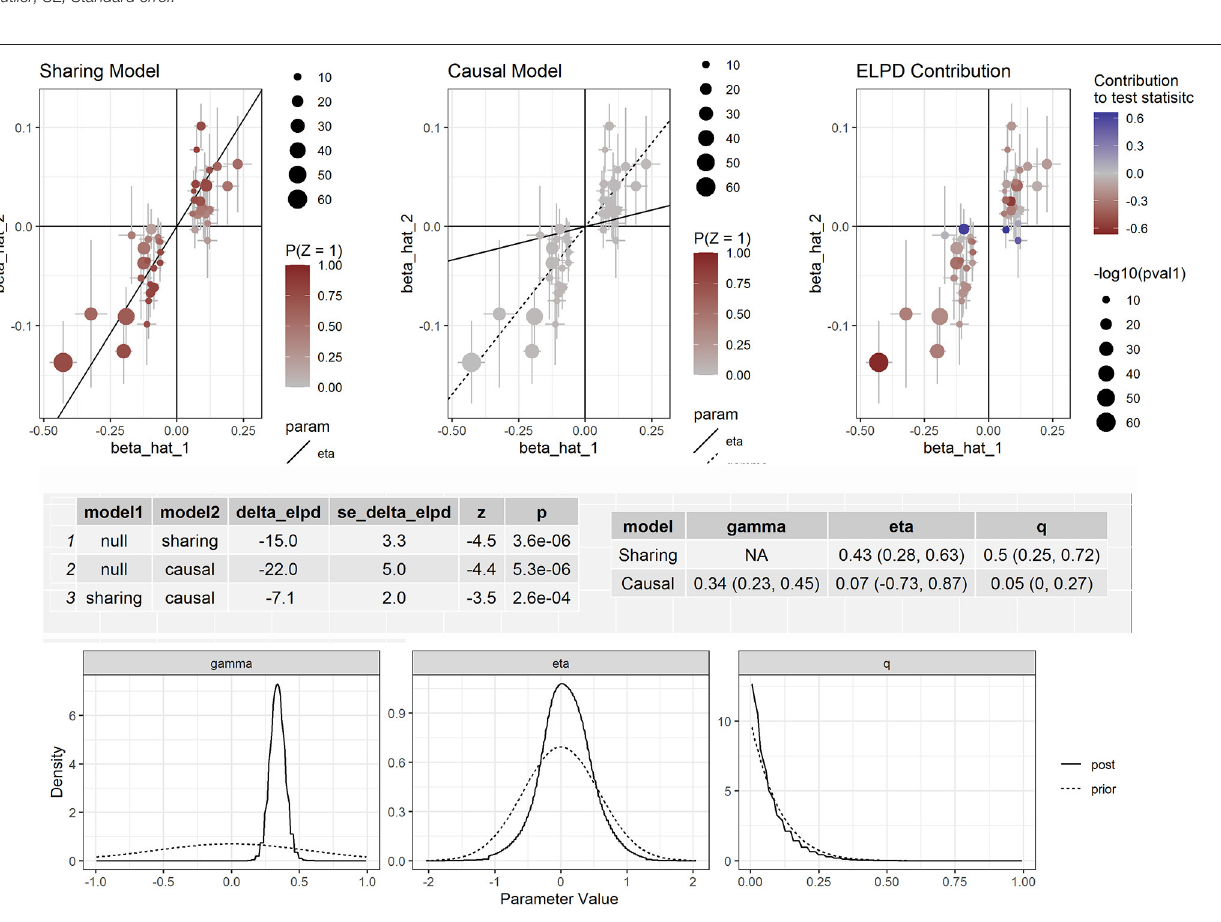
FIGURE 3 | Effect-size estimates and variant-level contribution to CAUSE test statistics for circulating apolipoprotein B and